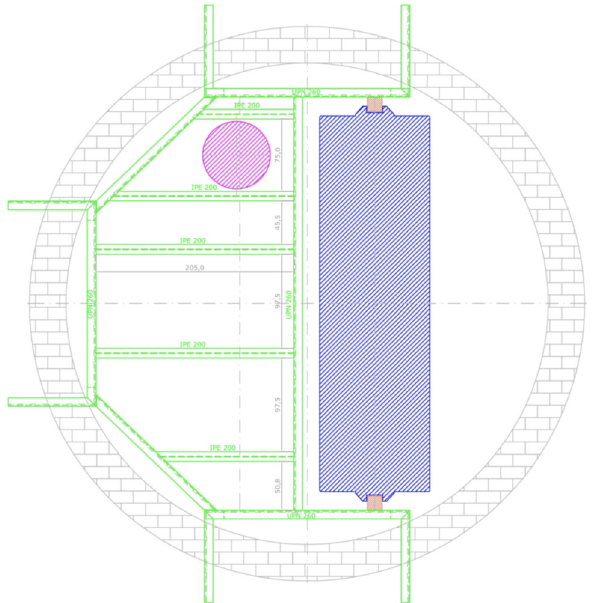
Fig. 8 Horizontal cross-sectional drawing of the mine shaft showing the stainless steel structure (green) for positioning the column, the column itself (magenta), and the elevator (blue)